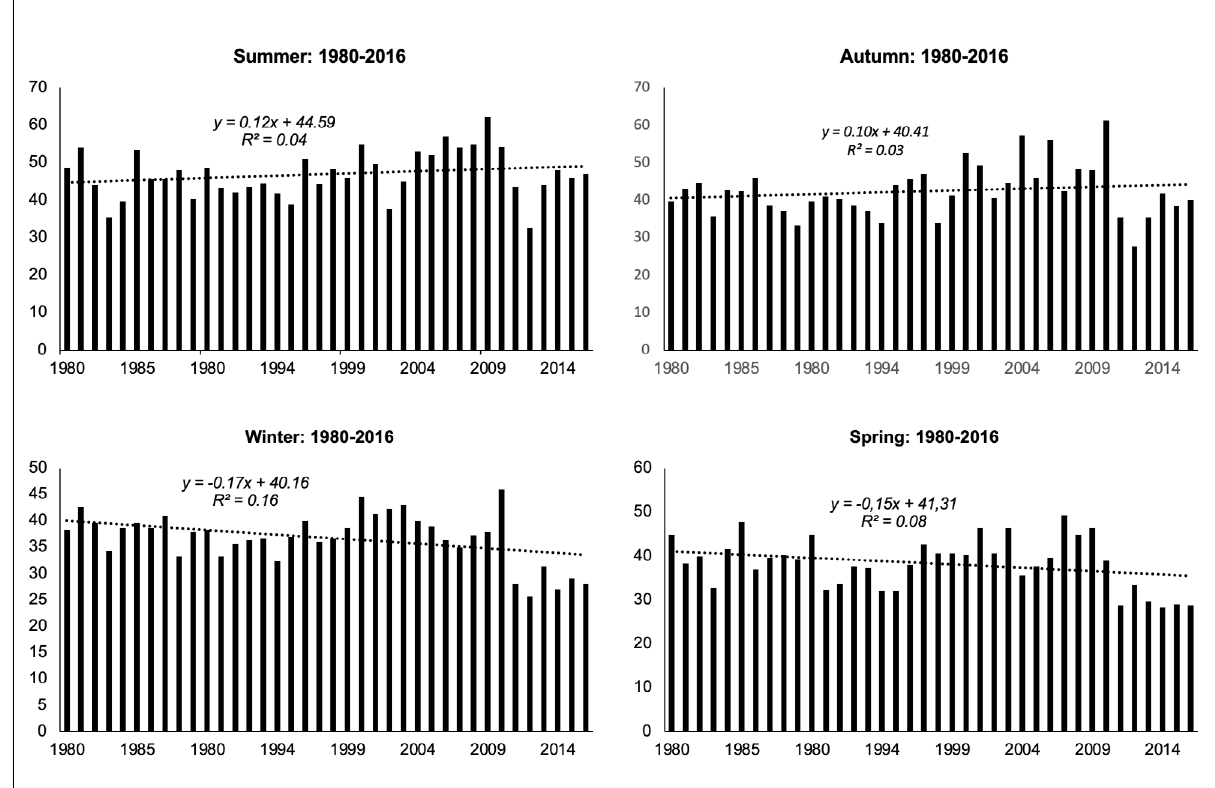
Figure 8: Mean seasonal relative humidity trends for northernmost Limpopo Province, 1980–2016.